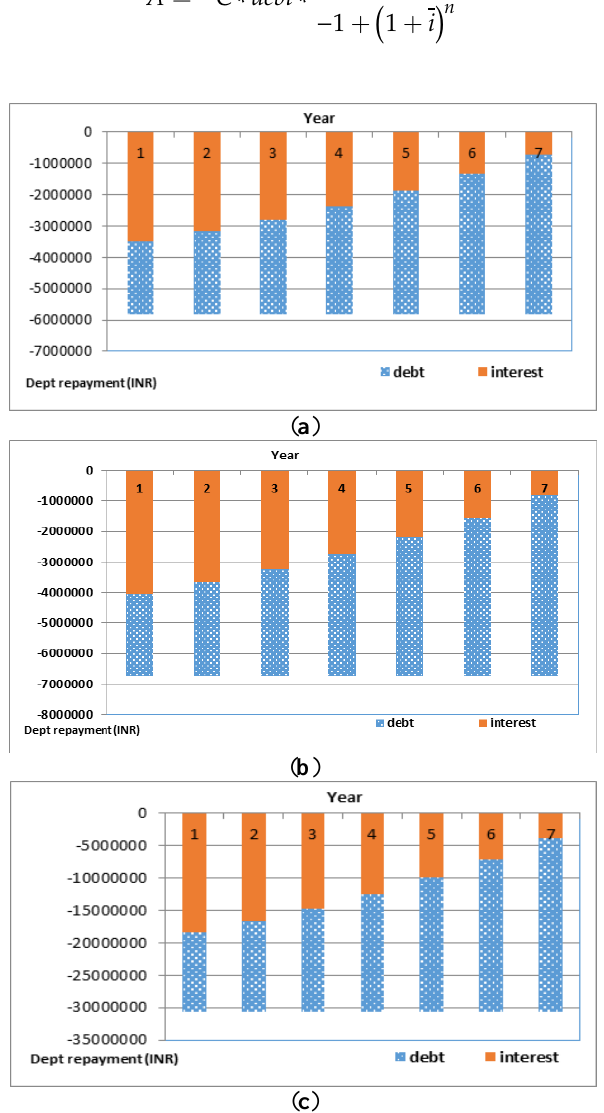
Figure 3. Debt repayment for ( a ) diesel generator project; ( b ) wind energy project; and ( c ) solar PV project.